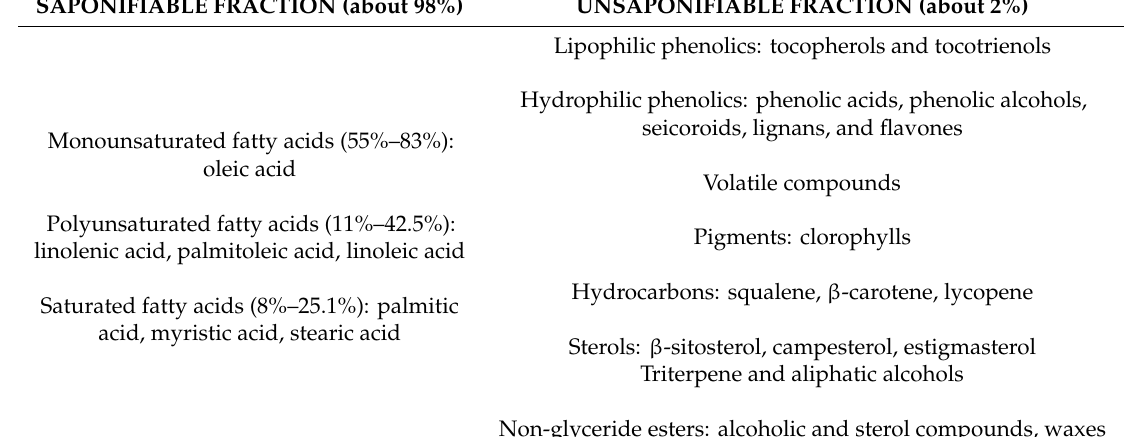
Table 1. Olive oil